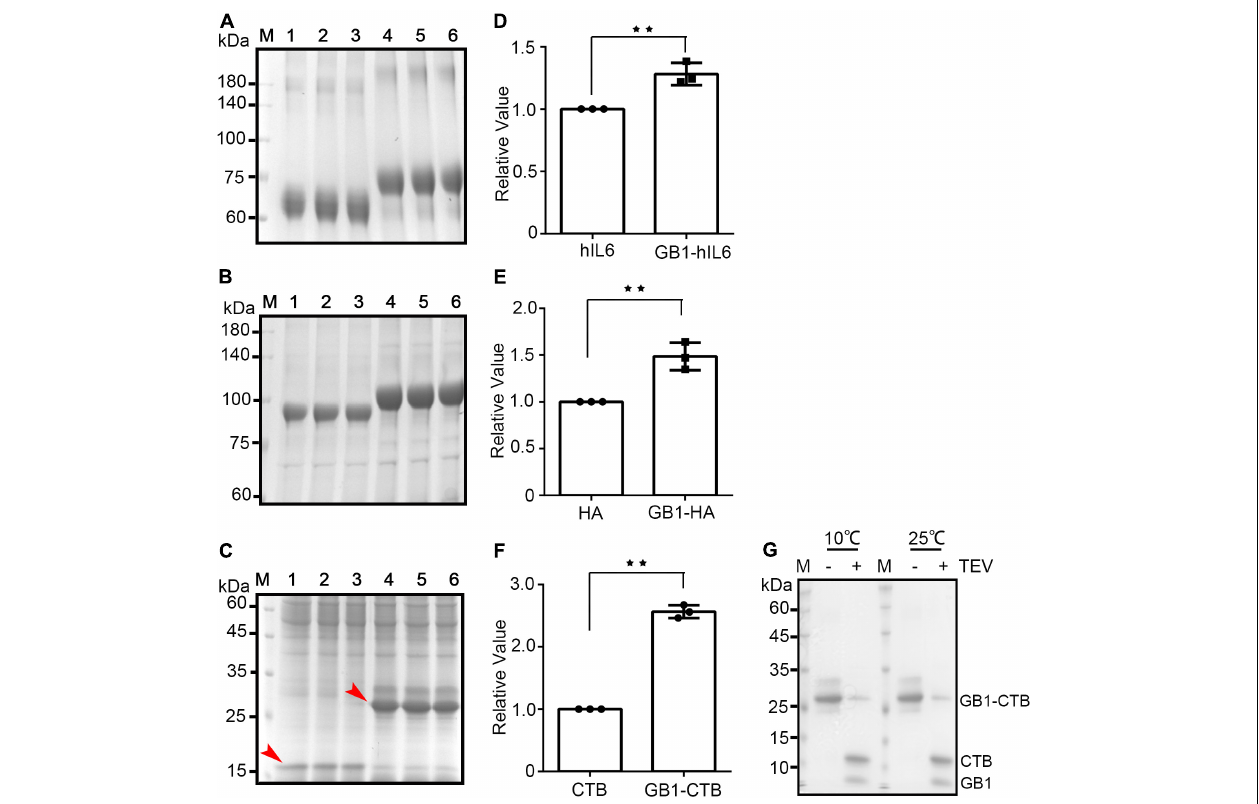
FIGURE 3 | GB1 enhances the expression of various target proteins in Nicotiana benthamiana . (A–C) SDS-PAGE analysis of target protein levels. The indicated target proteins were transiently expressed in Nicotiana benthamiana . These proteins from 0.1 g infiltrated tissues for each sample were purified using Ni 2 + -NTA affinity column chromatography and separated by SDS-PAGE. The gels were stained with CBB. (A) Lanes 1–3, purified hIL6; lanes 4–6, GB1-hIL6. (B) Lanes 1–3, purified HA; lanes 4–6, GB1-HA. (C) Lanes 1–3, purified CTB; lanes 4–6, GB1-CTB. Red arrows indicate the target proteins. (D–F) Quantification of signal intensity. The signal intensity of target protein bands in Figures (A–C) was quantified and represented in panels (D–F) , respectively, as relative values. Results in panels (D–F) are the mean ± SD ( n = 3). Asterisks indicate a significant difference (Student’s t -test; two asterisks indicate 0.001 < P < 0.05). (G) SDS-PAGE (15%) analysis of GB1-CTB cleaved by TEV protease at 10 and 25 ◦ C